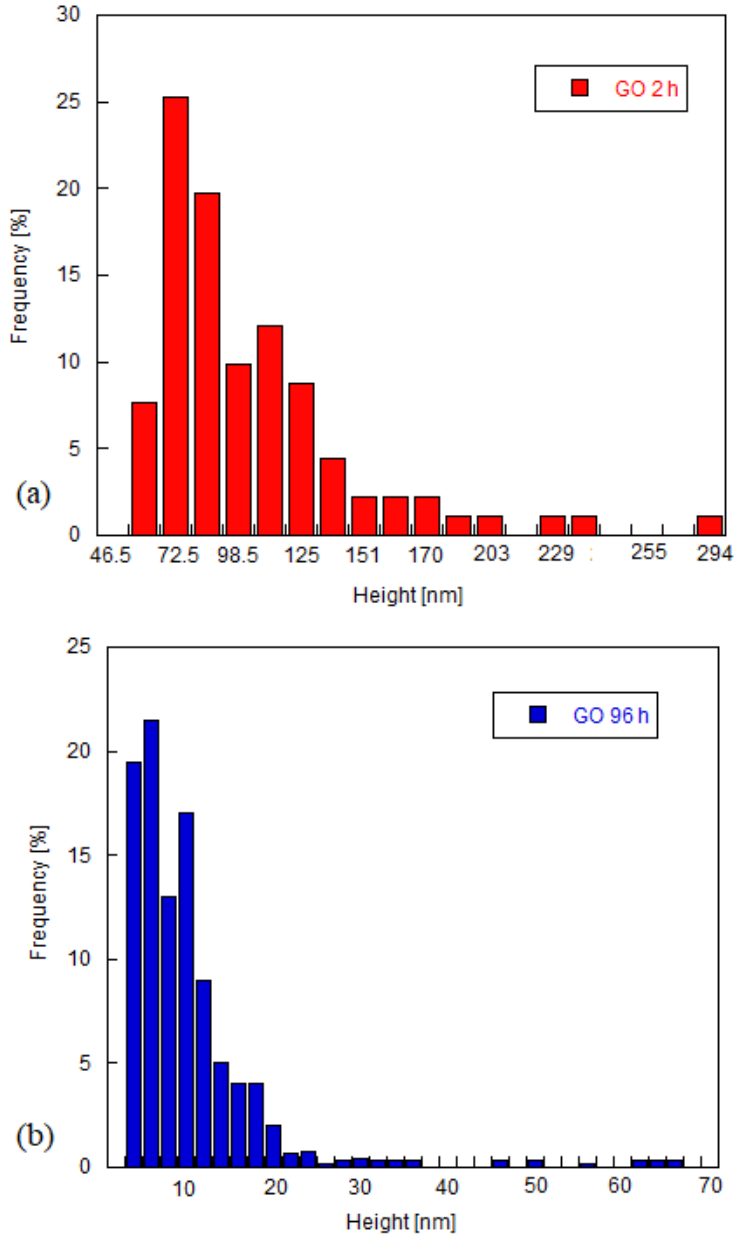
Figure 6. Histograms of frequency (%) as a function of their height (nm) of GO sheets of ( a ) 2 h of oxidation and ( b ) 96 h of oxidation.